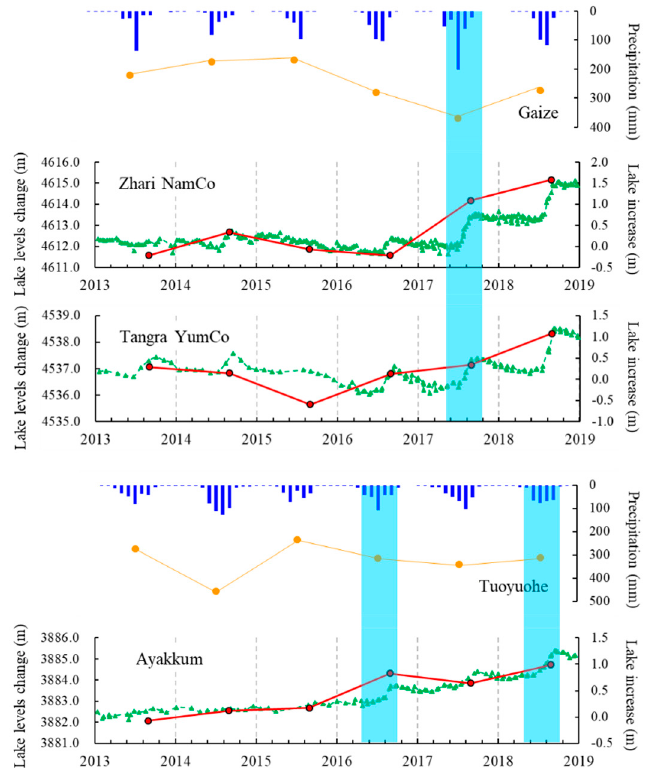
Figure 8. Observed lake level changes and precipitation variations for typical lakes between 2013 and 2018. The right Y-axis “lake increase” refers to level changes relative to the previous year (shown as red dots in the plot). The highest water level during the year is used as the annual lake level. Blue bars represent monthly precipitation at the Gaize and Tuotuohe meteorological stations, and the total annual precipitation was calculated. The light blue stripes indicate the corresponding changes in precipitation and lake